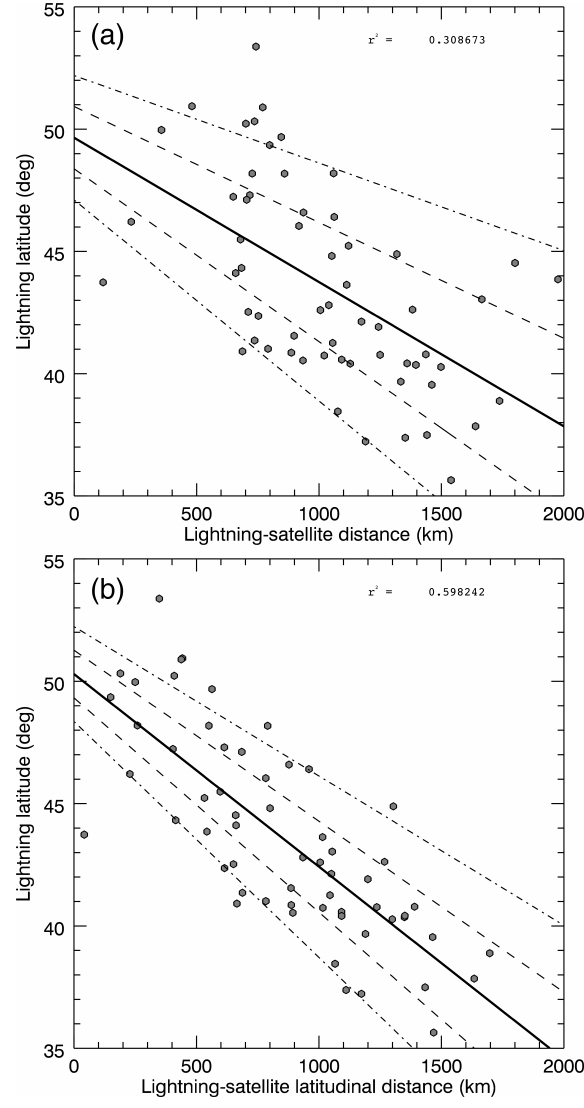
Figure 6. Panel ( a ): lightning latitude (deg) vs. lightning–satellite distance (km). Panel ( b ): lightning latitude (deg) vs. latitudinal lightning–satellite distance (km). The solid line represents the lin- ear regression, the dashed line the confidence limits at ± 1 σ (68%), and the dash-dot line the confidence limits at ± 2 σ (95%).